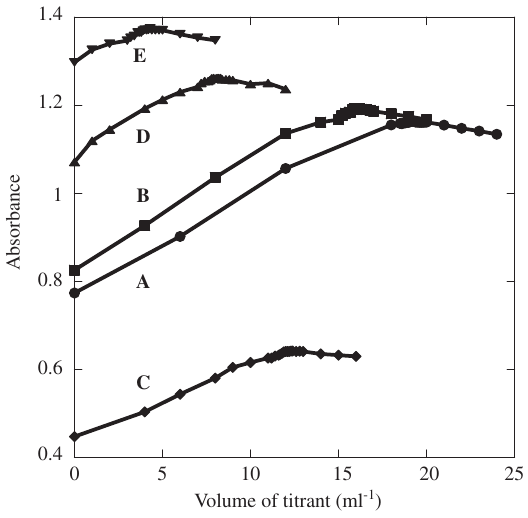
Figure 7 Photometric back titration curves for PHMB-HCl with a 1.0 × 10 -4 eq mol l -1 PDADMAC standard solution. Sample solution: PHMB-HCl (77.5 ml)+1.0 × 10 -4 eq mol l -1 PVSK (20.00 ml)+1.0 × 10 -3 mol l -1 CV (2.0 ml)+1 mol l -1 HCl (0.52 ml). Concentration of PHMB-HCl: